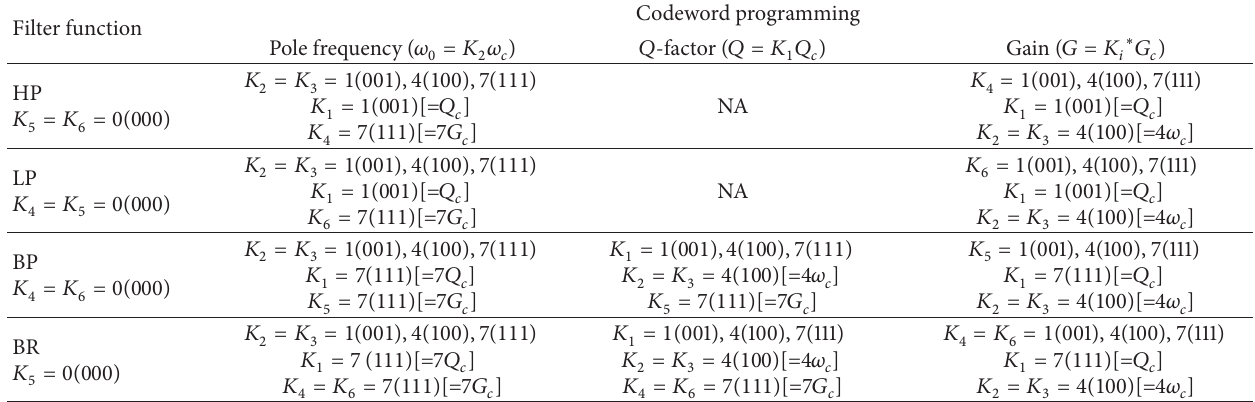
Table 4: Codeword programming of filter